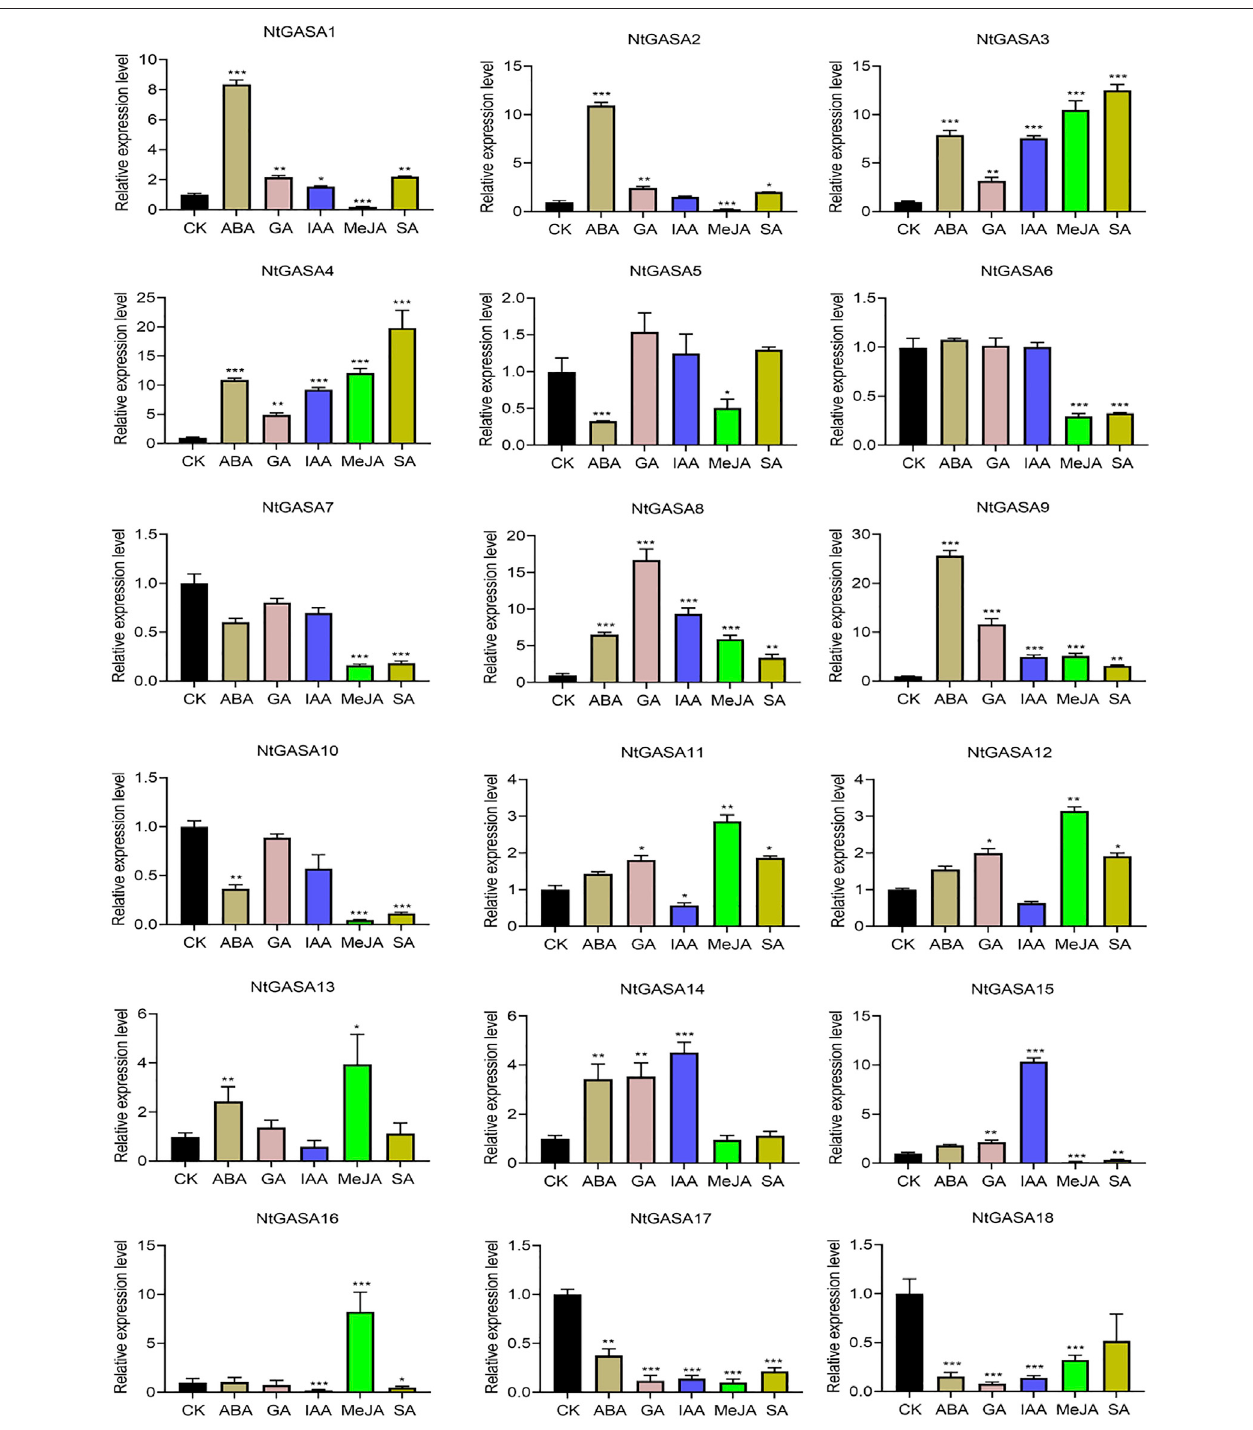
FIGURE 8 | Expression patterns of NtGASA genes under various phytohormone treatments. 3-week-old seedlings treated with 10 μ M ABA, 10 μ M GA, 10 μ M IAA, 10 μ M SA, and 50 μ M MeJA were collected for expression analysis, seedlings treated with 1% (v/v) DMSO served as controls. Each value represents the mean ± standard error of three biological replicates. Asterisks denote signi fi cant differences between the hormone treatment and control sample. (Student ’ s t -test, * p < 0.05, ** p < 0.01, *** p < 0.001).